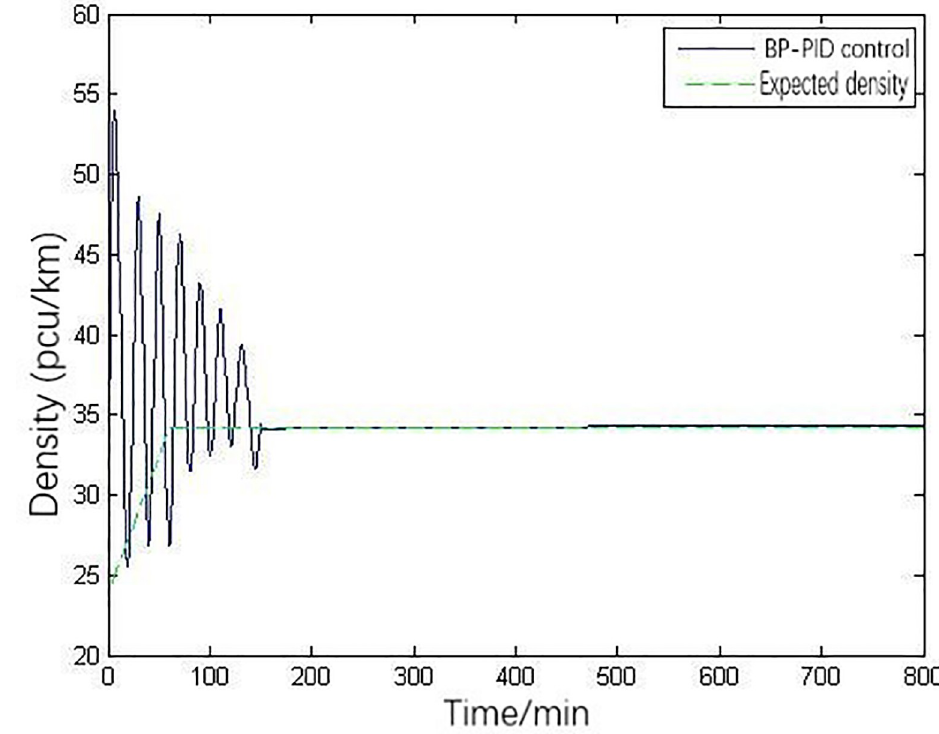
Fig 8. Density variation under BP-PID